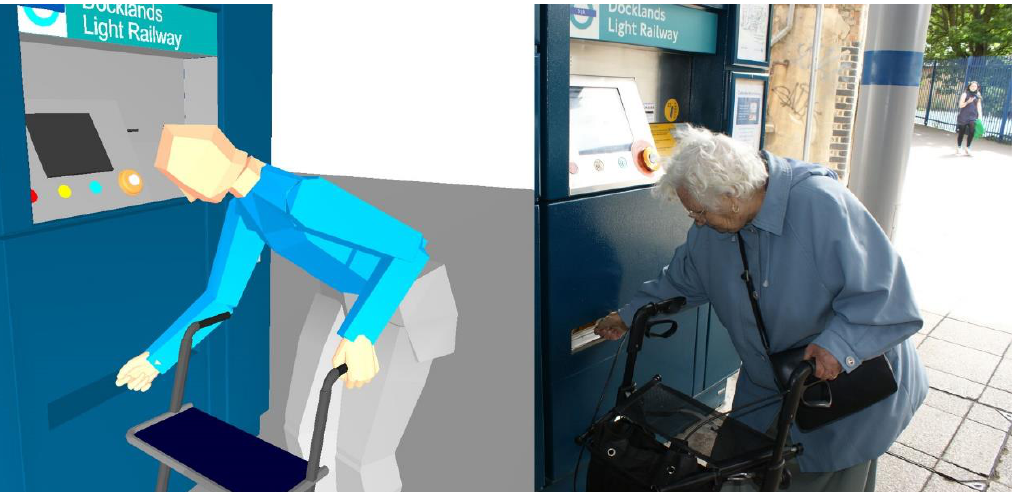
Figure 2. HADRIAN–SAMMIE simulation of interacting with a ticket machine (left) and real-world validation (right) dur- ing trials at the DLR station in Greenwich,